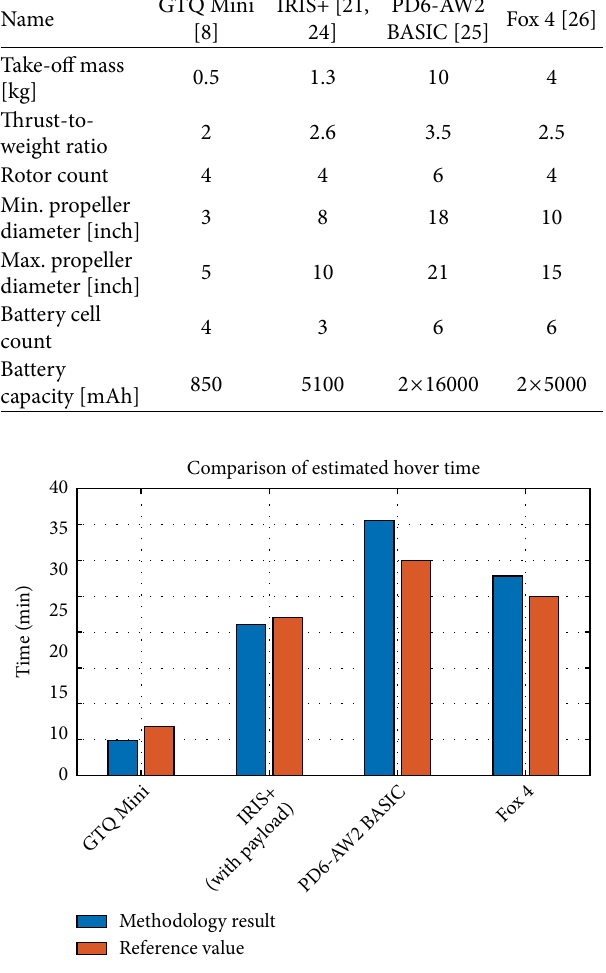
Figure 12: Comparison of calculated hovering time with longest expected time.